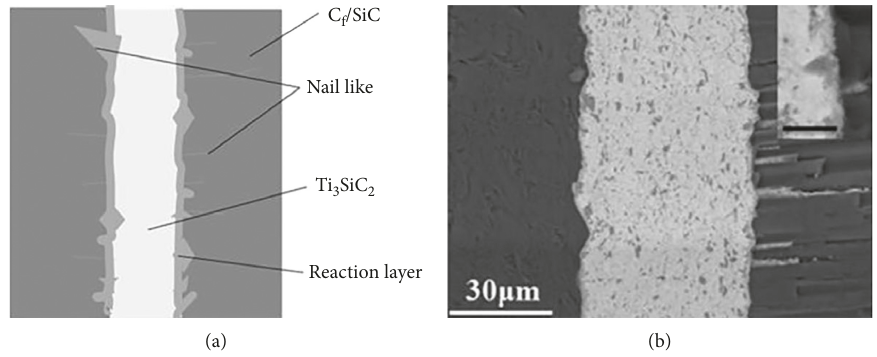
Figure 16: (a) The schematic diagram of “nail” like and (b) BSE image